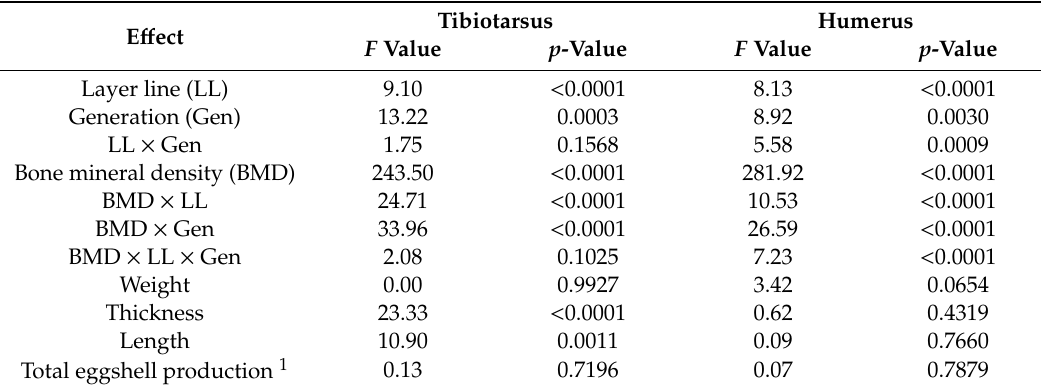
Table 3. The e ff ects of layer line (LL), generation (Gen), bone mineral density (BMD), bone weight, bone thickness, bone length, total eggshell production and significant interactions on bone breaking strengths of the tibiotarsus and humerus in laying